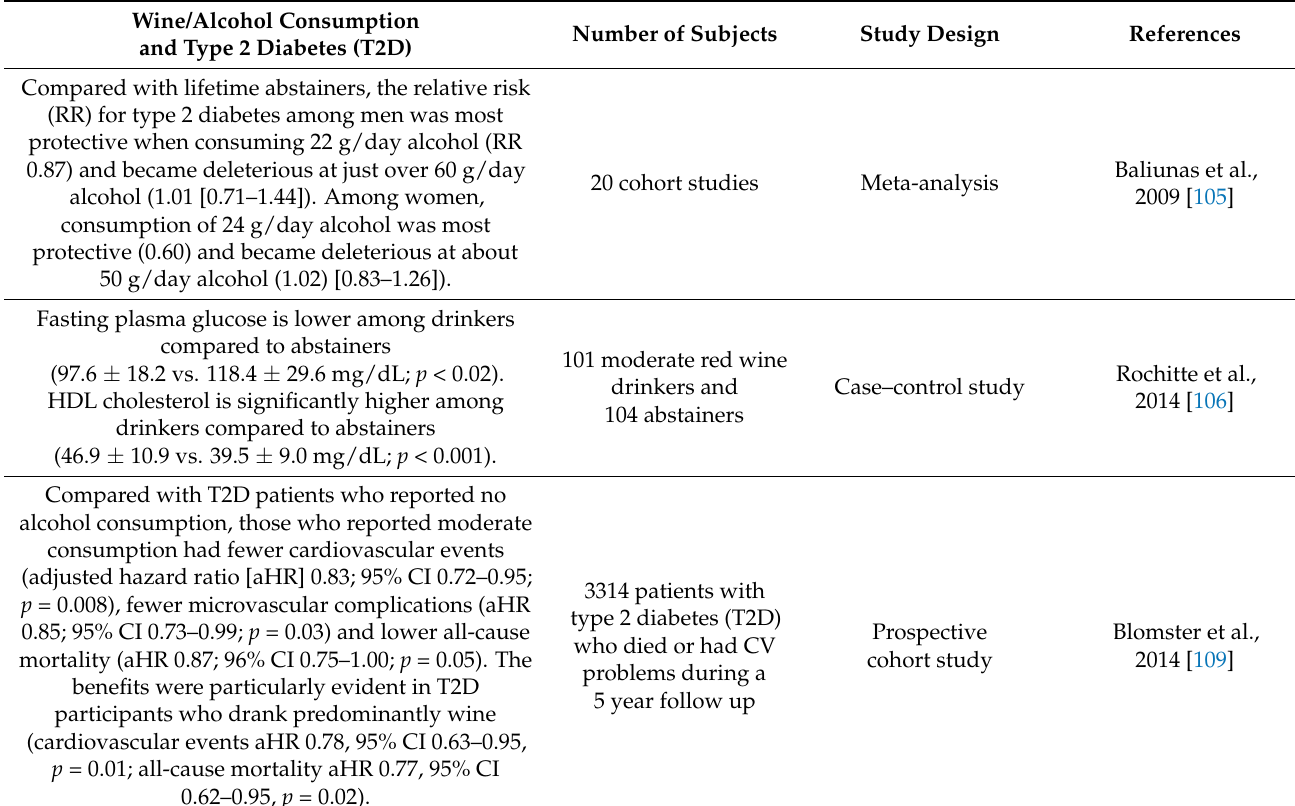
Table 2. Studies on wine consumption and type 2